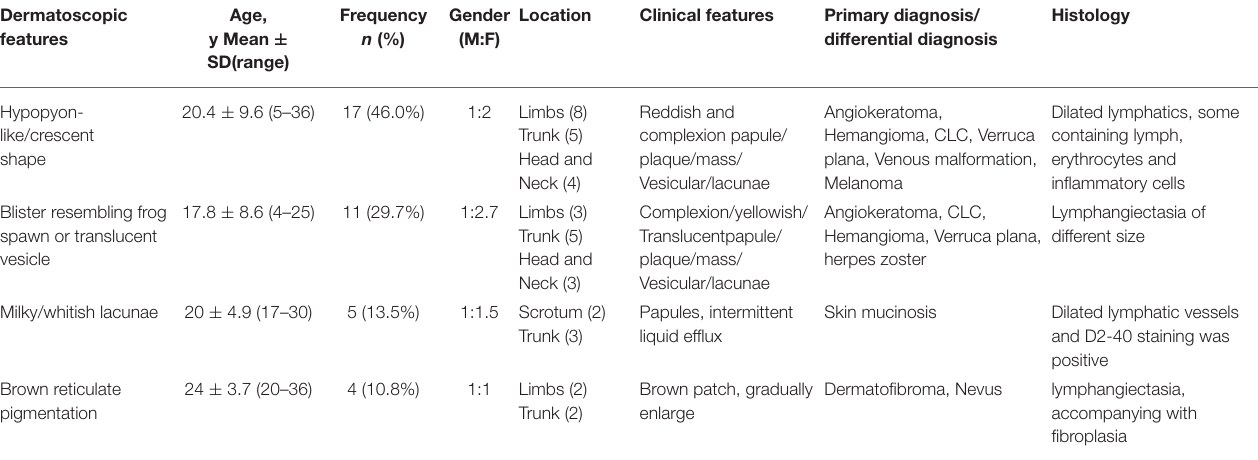
TABLE 1 | The clinical manifestations, dermatoscopic findings, and histological features of patients with cutaneous lymphangioma circumscriptum (CLC). Dermatoscopic features